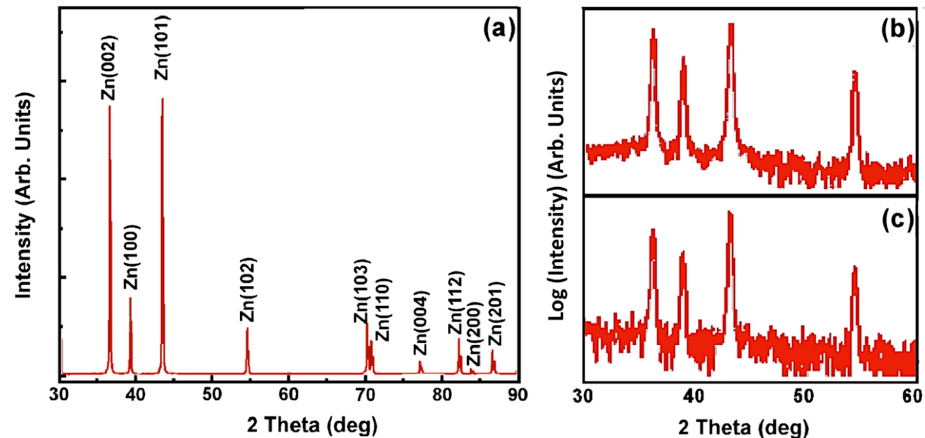
Figure 8. ( a ) BB-XRD diffraction pattern of the samples grown by thermal spray. GI-XRD diffraction patterns of the same samples obtained using an incidence angle of ( b ) 5° and ( c ) 1.5°.